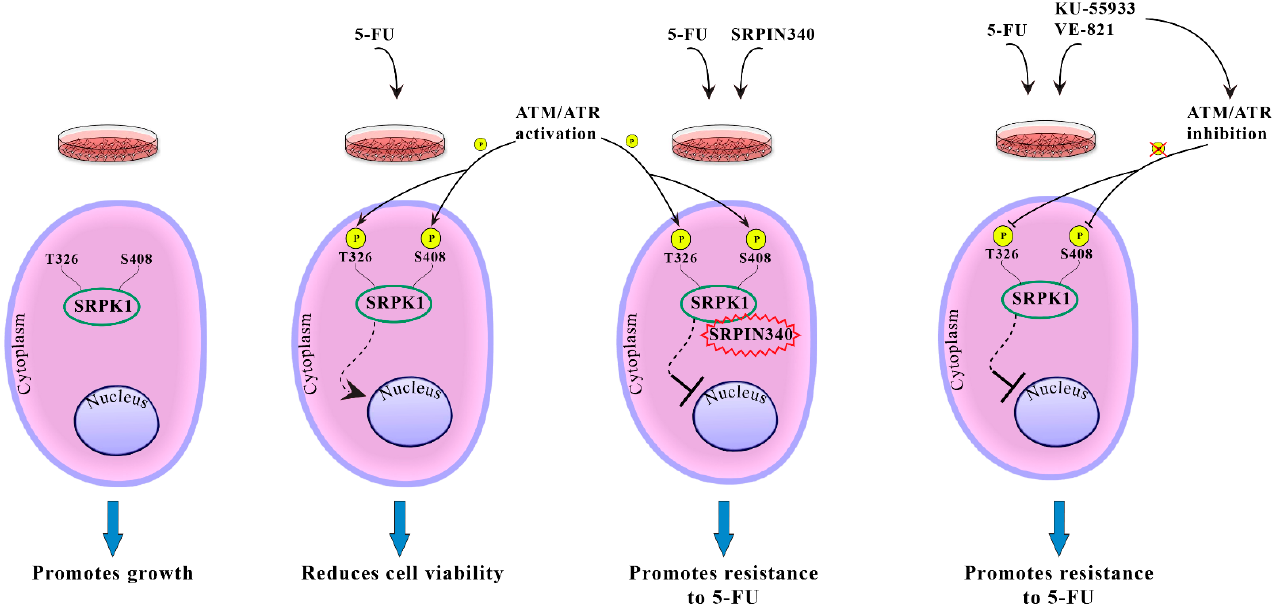
Figure 11. Putative model showing the effect of phosphorylation of Thr326 and Ser408 on the SRPK1 subcellular localization and function.